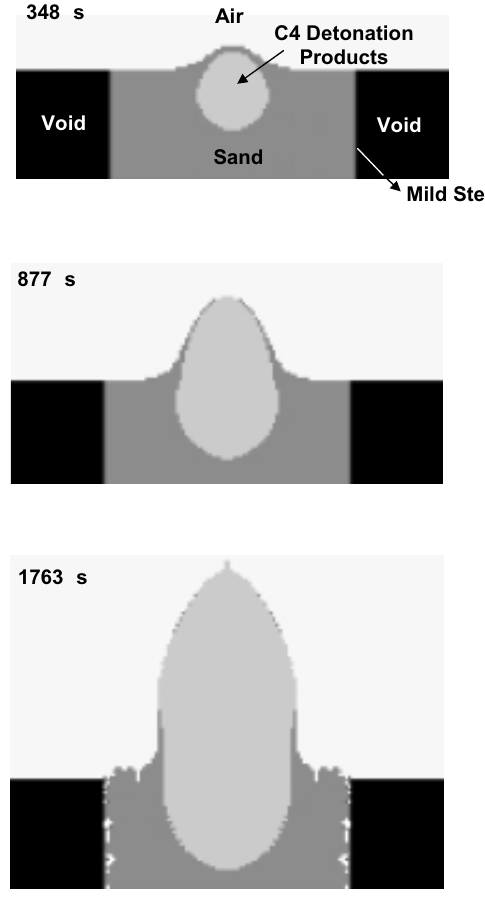
Fig. 7. Temporal evolution of material deformation in the case of landmine detonation (DOB = 8 cm) in the case of fully saturated sand. deficiencies of the present material model for sand since the role of sand is least critical in the case of a flush-buried